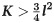
The channel's total profit with β in K>34l2.